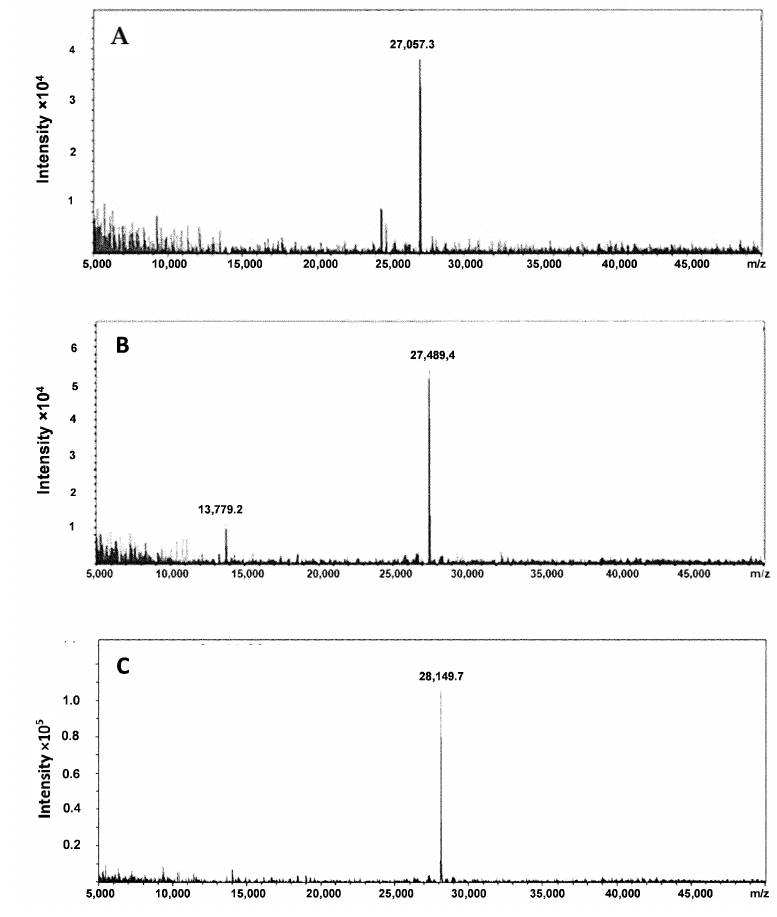
Figure 3. Deconvolution of mass spectra of ( A ) G3-G 3 C, ( B ) G3-E 3 C, and ( C ) G3-(G 3 S) 3 C. Table 1. Results of the LC-MS analysis of non-labeled DARPin G3 variants having the amino acid- containing chelating sequences G 3 C, E 3 C, and (G 3 S) 3 C at the C-terminus. Construct Mw calc (Da) Mw obs